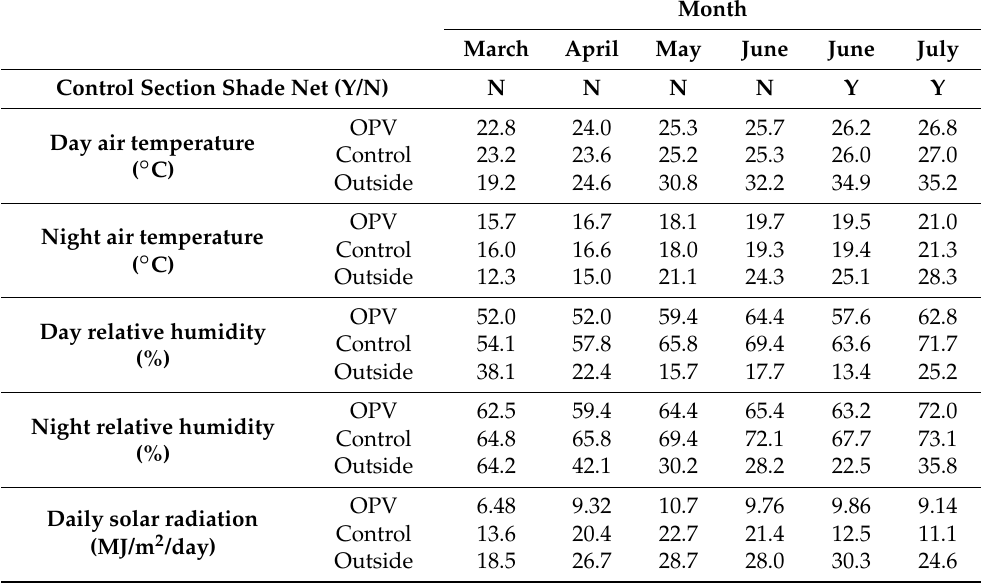
Table 1. Average daytime and nighttime measurements for air temperature, relative humidity, and canopy-level daily solar radiation sum in the OPV-shaded (‘OPV’) and non-OPV-shaded (‘Control’) sections of the greenhouse, and outside above the greenhouse. See Materials and Methods section for description of sensor locations.